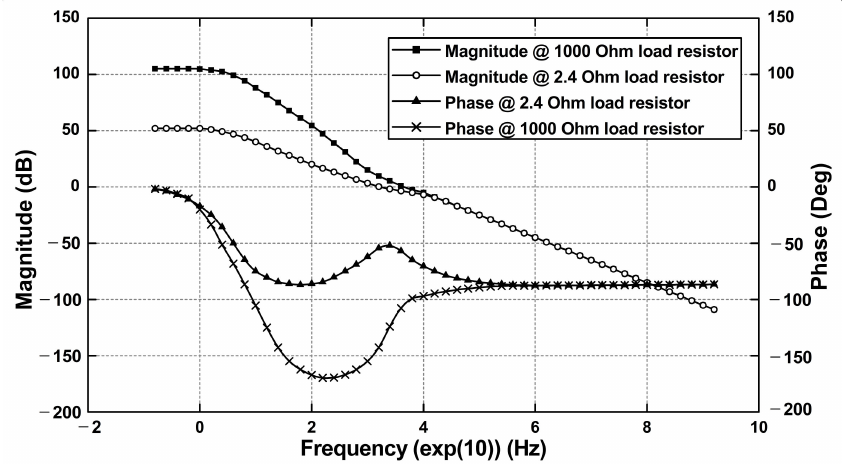
Figure 8. Magnitude and phase of charge control when R O4 = 2.4 Ω and R O4 = 1000 Ω .